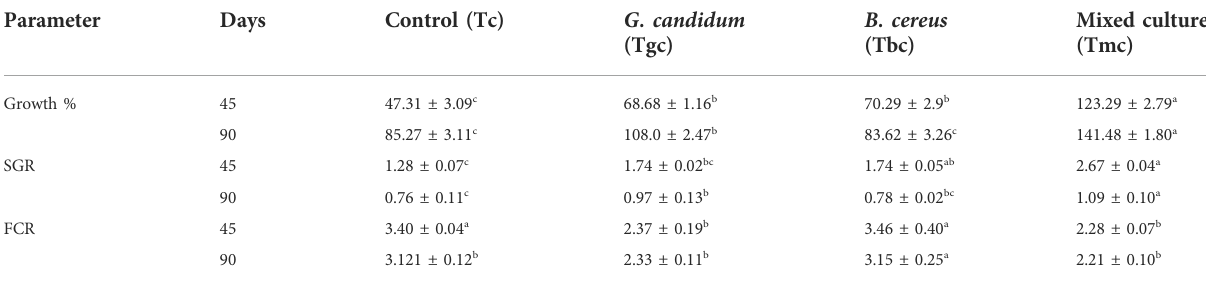
TABLE 2 Impact of feeding probiotic microorganisms (10 9 CFU/gm diet) in single and mixed culture on growth performance of Labeo rohita. Parameter Days